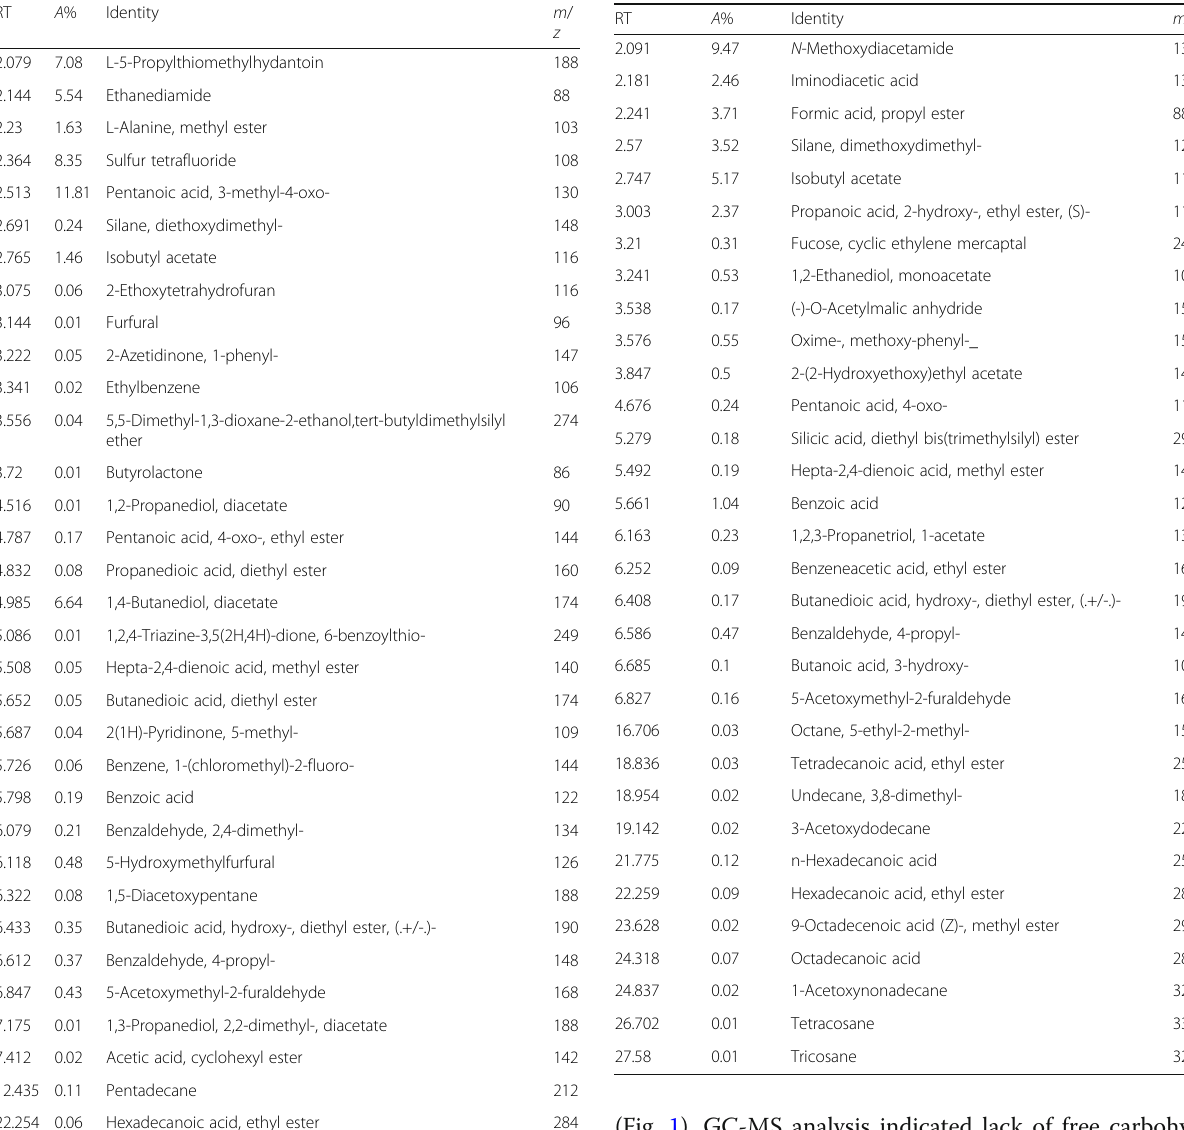
Table 1 Volatile compounds identified in P. guajava extract Table 2 Volatile compounds identified in P. edulis extract